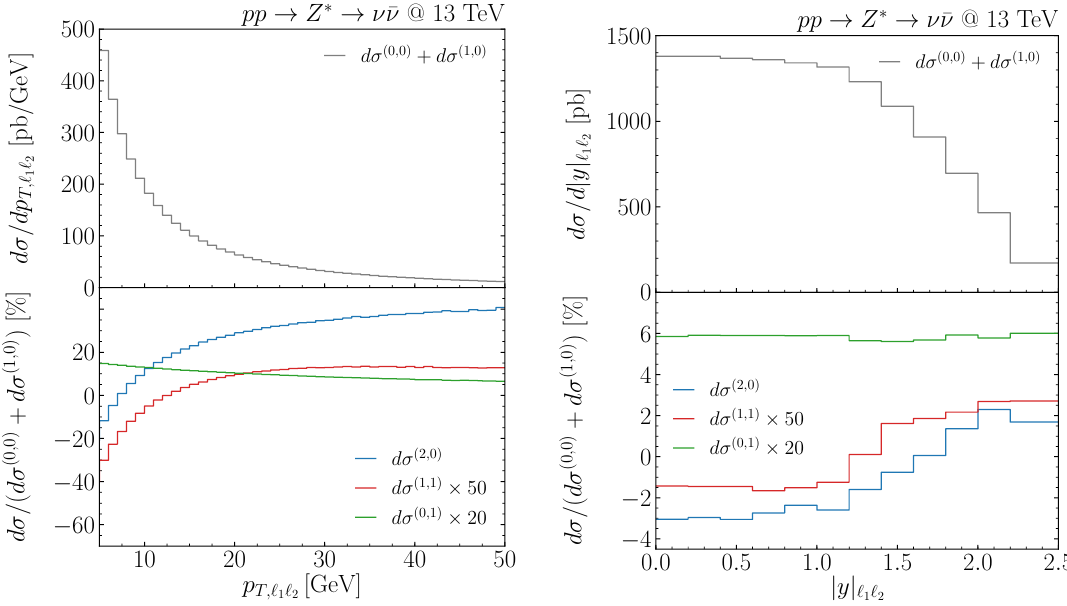
Figure 3 . Lepton-pair transverse momentum (left) and rapidity (right) distributions. The upper panel shows the NLO QCD prediction, while the lower panel shows the NNLO QCD (blue), NLO QED (green) and mixed (red) corrections, normalized to the NLO